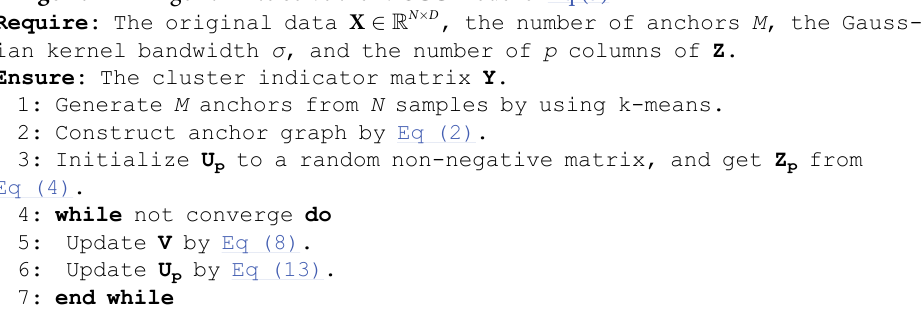
Algorithm 1 Algorithm to solve the RLSCC model of Eq